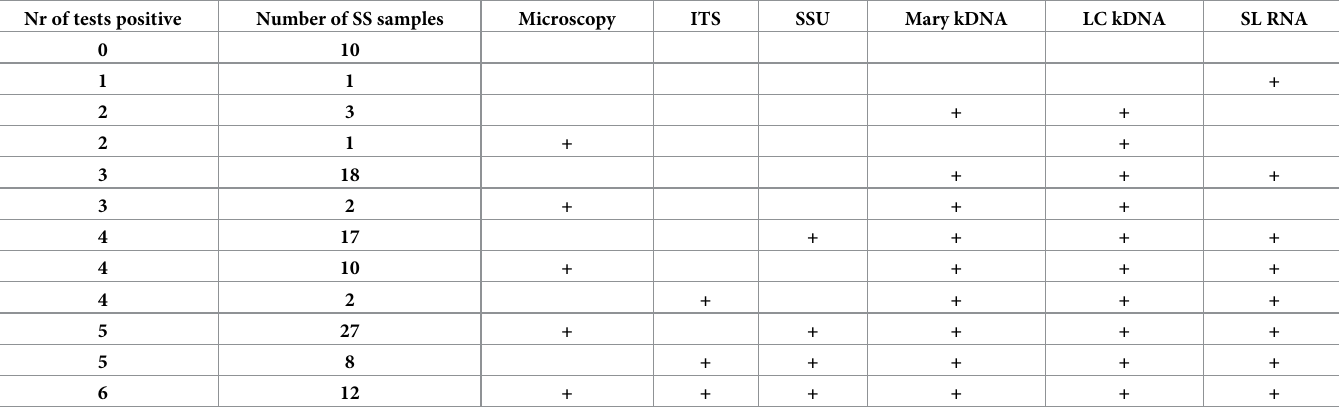
Table 2. An overview of a number of tests and the number of skin scraping samples that gave a positive result for all observed combinations of index tests. Nr of tests positive Number of SS samples Microscopy